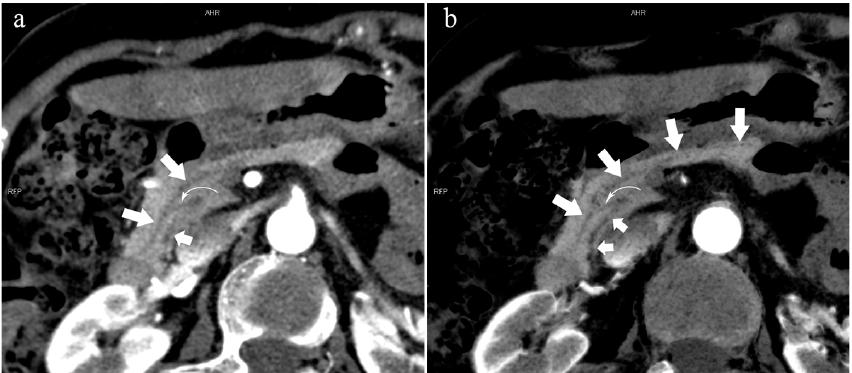
Figure 8. Type 4c. A 73-year-old female patient with multiple stones of the intrahepatic bile duct. ( a ): MIP [45keV MEI(+)] shows that MPD (long arrow) flows into MiP, and APD (short arrow) flows into MP with a small communication branch (bent arrows) between them. ( b ): MinIP [45keV MEI(+)] improves visualization of small pancreatic ducts and their branches. MPD refers to anatomically large and functionally dominant ducts.